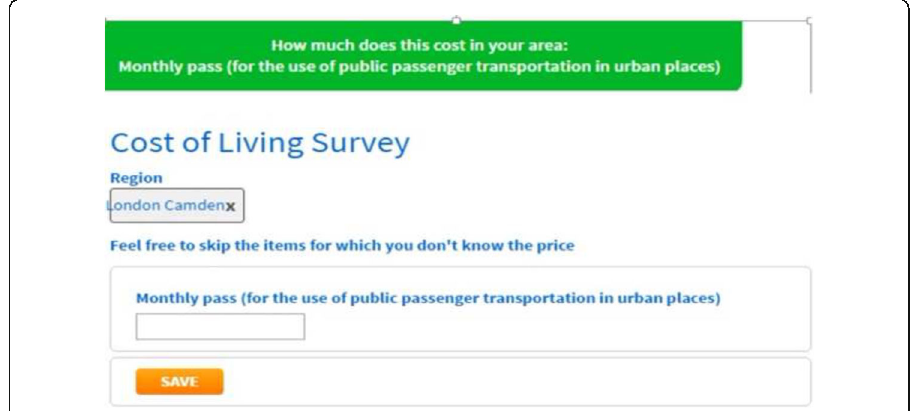
Fig. 1 The banner and the “ item of the day ” question on the British website for 7th Match 2017. Source: